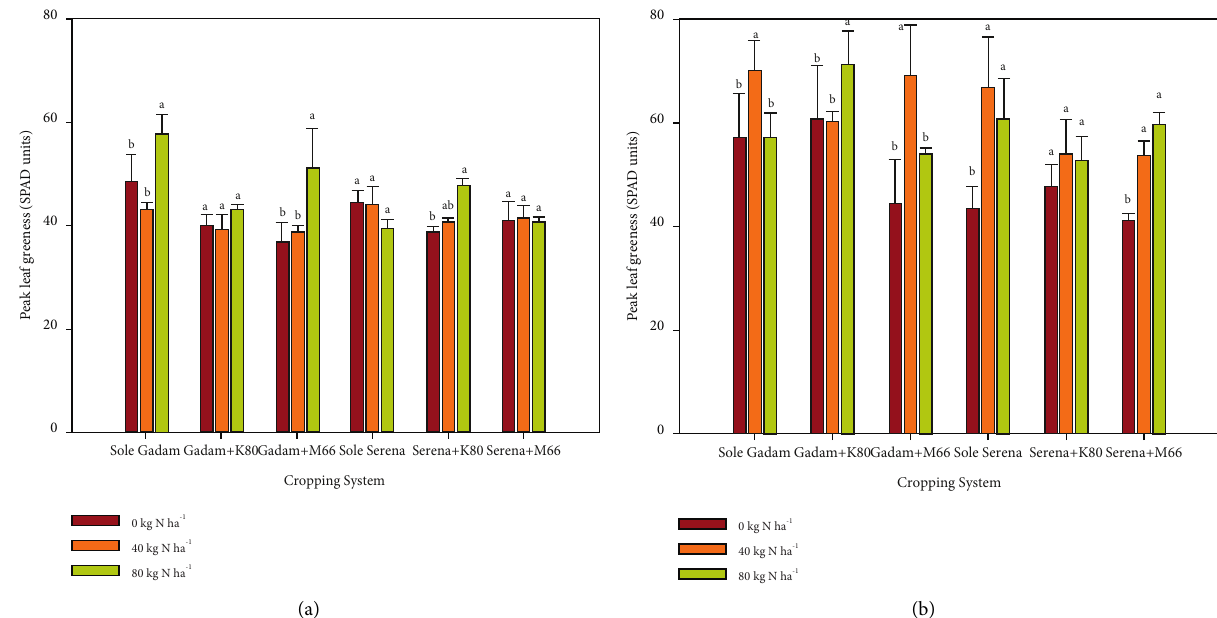
Figure 3: Peak leaf greenness (SPADmax) of two sorghum varieties (Gadam and Serena) grown in sole and intercrop system with two varieties of cowpea (K80 and M66) and interactions with 0, 40, and 80kg N ha − 1 at the KALRO research stations in Igoji (a) and Katumani (b) during 2018/2019 short rains. Mean values followed by the same letter are not significantly different. The bars indicate the mean standard errors